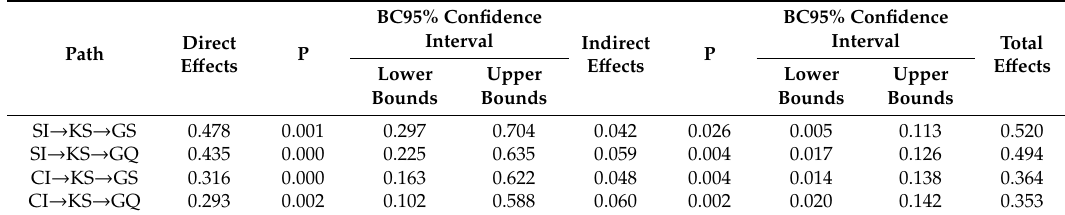
Table 7. Mediating e ff ect of knowledge spiral.